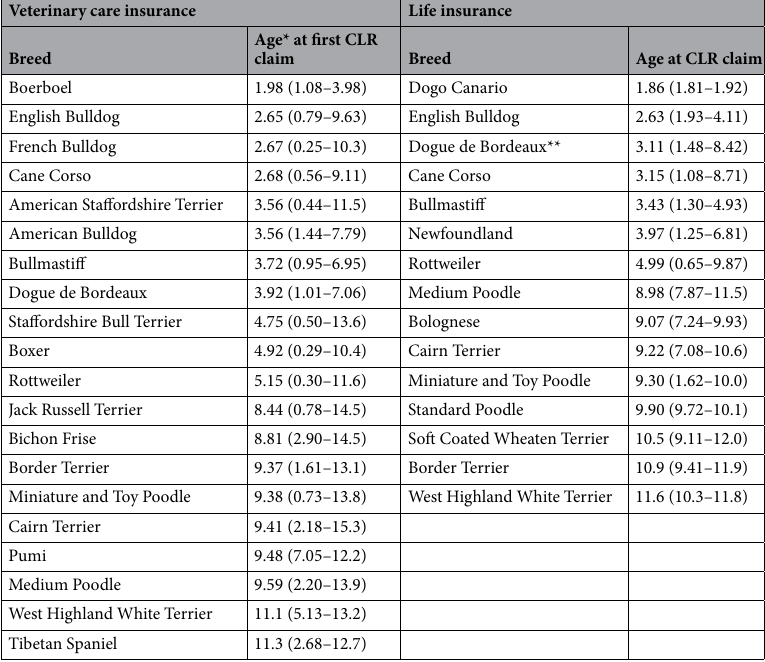
Table 3. Previous diagnoses by organ system in dogs with and without cruciate ligament rupture (CLR), in a cohort of dogs insured in Agria Pet Insurance (2011–2016). *The proportion of dogs with diagnoses in these organ systems was significantly higher in dogs with CLR, after Bonferroni correction based on the number of organ systems, n = 12. **In total 4167 dogs with veterinary care claims for CLR. ***All dogs with veterinary care insurance, except for the dogs with CLR